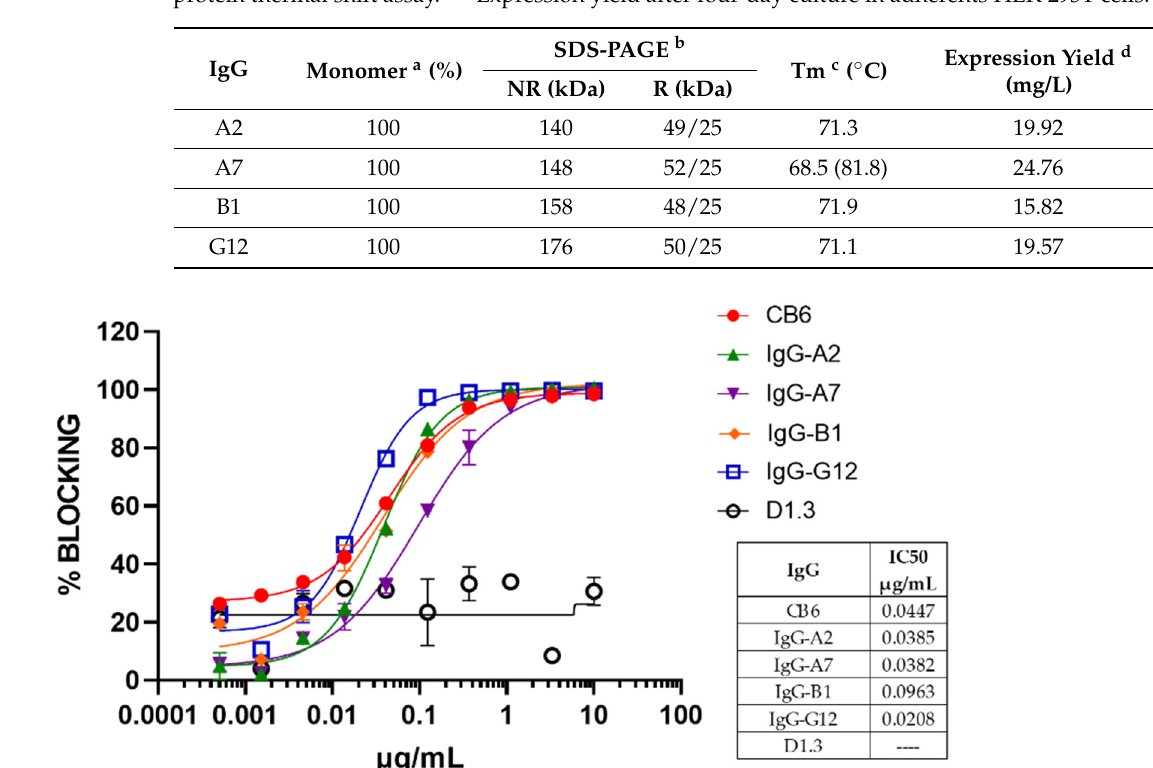
Figure 3. RBD:hACE2 blockade assay for representative IgGs. All IgGs are blocking the RBD:hACE2 interaction with a dose–response behavior in a concentration interval of 0.001–10 µg/mL. The data were fitted to a four-parameter dose–response curve using GraphPad Prism 9.3.1. Binding to RBD-WT, RBD-DT, as well as RBD-O, as assessed by ELISA, is shown in